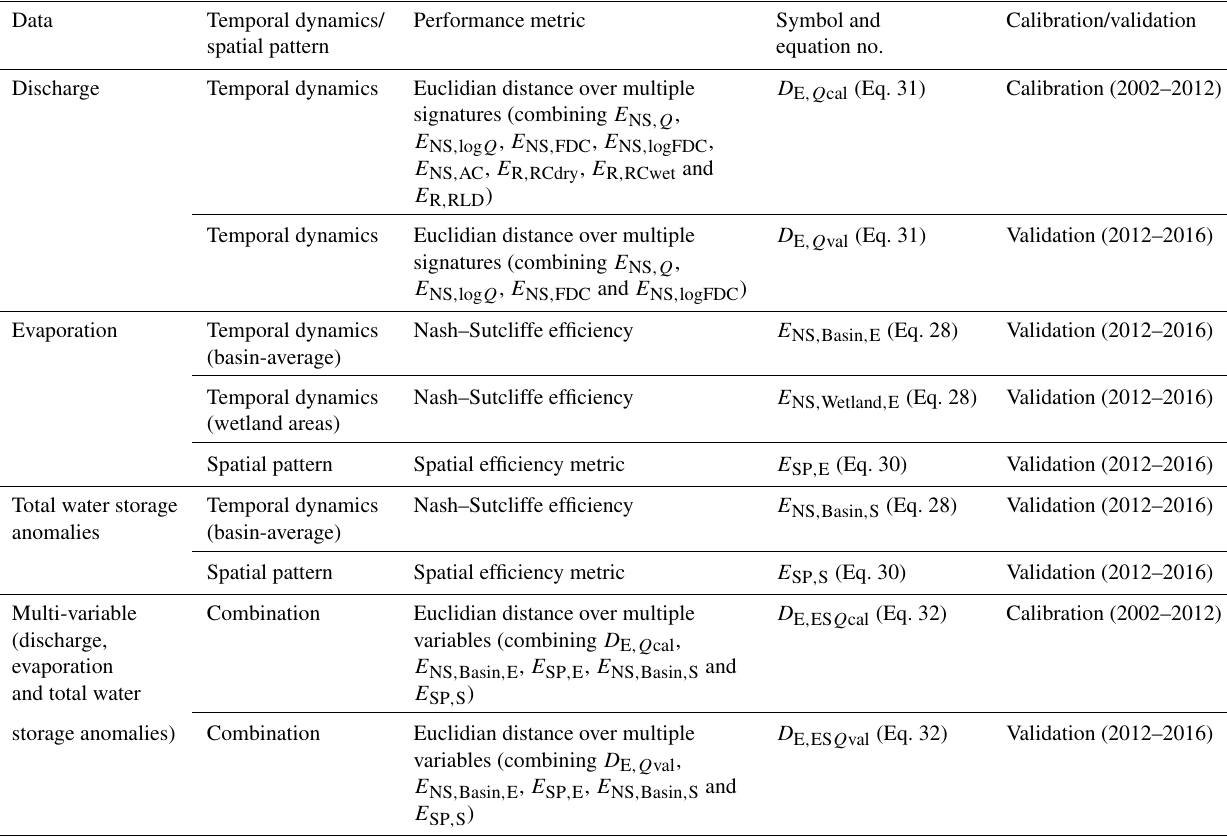
Table 5. Overview of the applied model performance